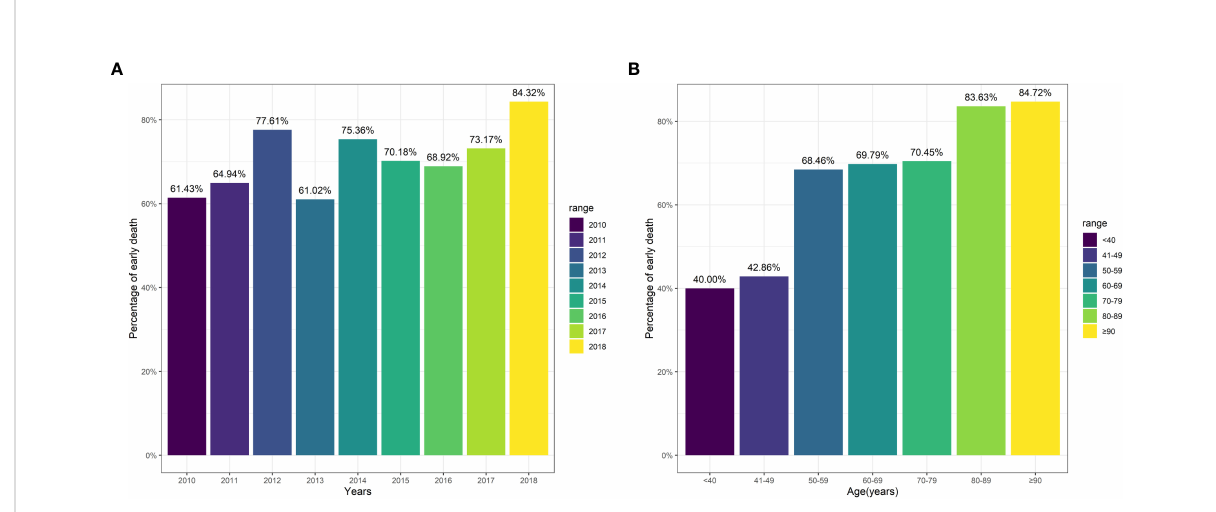
FIGURE 2 Three-month mortality among patients strati fi ed by variables. (A) Year of diagnosis; (B)